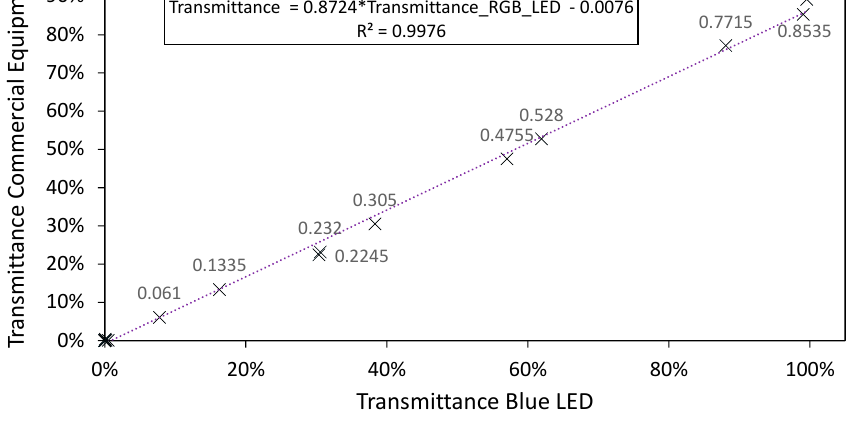
Figure 11. Fit of the LED whose peak wavelength is 460 nm.